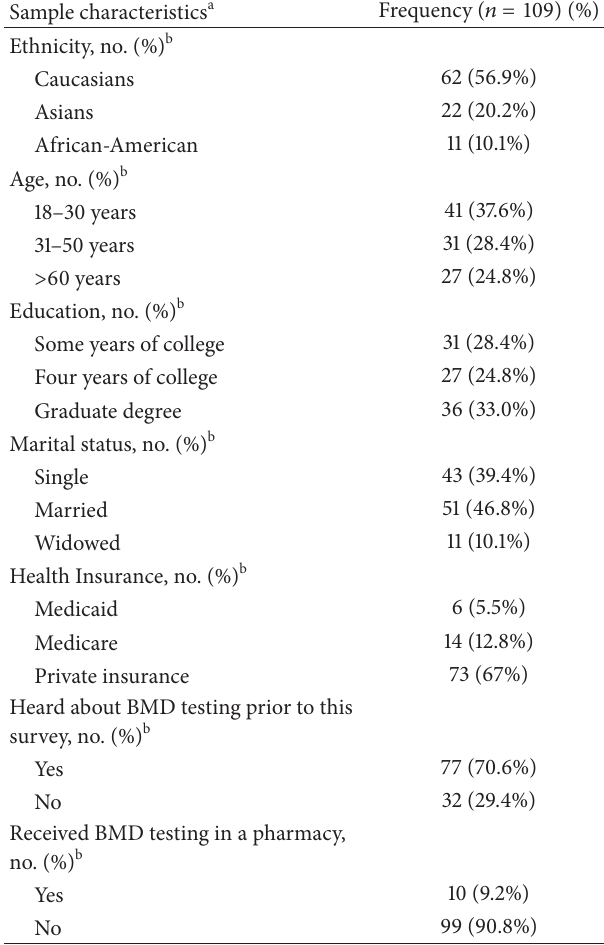
Table 2: Study sample characteristics. Table 3: Association between measures of outcomes and intention to